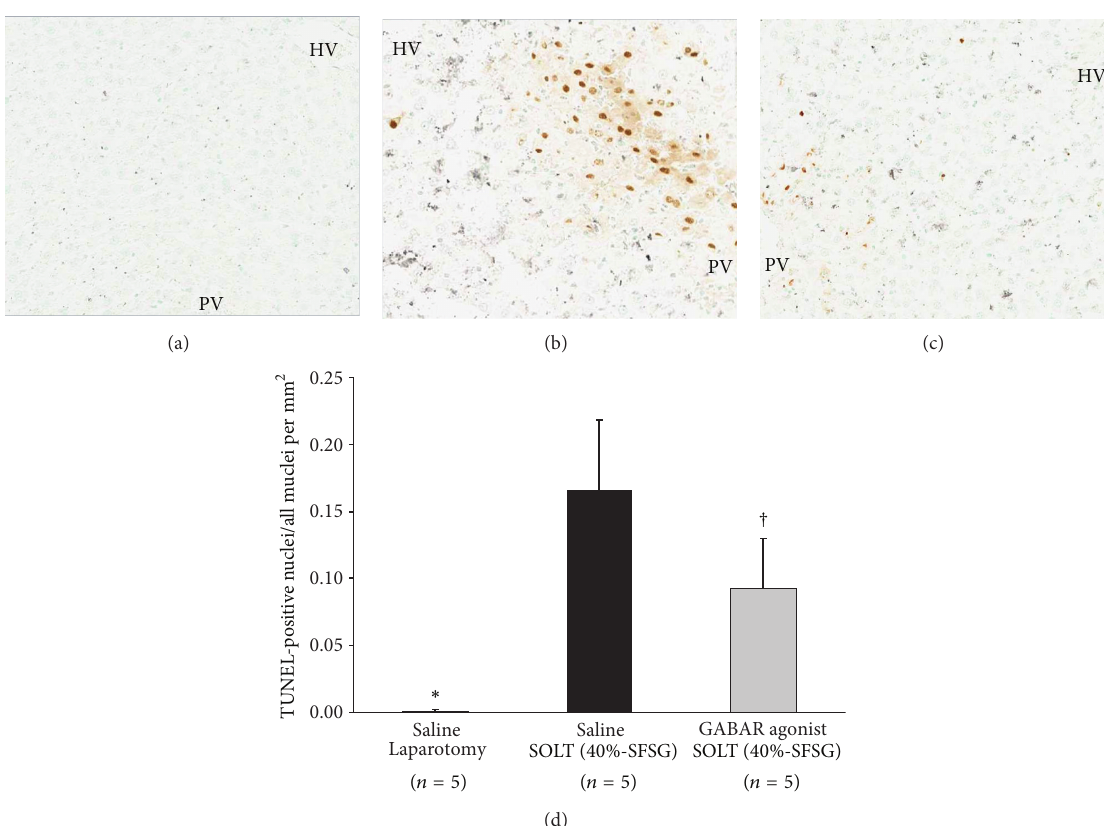
Figure 3: Immunohistological assessment by TUNEL. (a) Laparotomy with saline: TUNEL, × 100. (b) SOLT with saline: TUNEL, × 100. (c) SOLT with GABAR agonist: TUNEL, × 100. (d) Ratio of TUNEL-positive nuclei. There were significant differences between laparotomy and SOLT with saline ( 𝑃 < 0.05 ∗ ) and between SOLT with saline and SOLT with GABAR agonist ( 𝑃 < 0.05 † ). GABAR, 𝛾 -aminobutyric acid receptor; HV, hepatic vein; SFSG, small-for-size graft; SOLT, split orthotopic liver transplantation; PV, portal vein; and TUNEL, terminal deoxynucleotidyl transferase-mediated deoxyuridine triphosphate nick-end labeling. 2.59 ± 0.66 ; 𝑃 = 0.0007 ) and between SOLT with saline and SOLT with GABAR agonist ( 2.59 ± 0.66 versus 0.83 ± 0.25 ; 𝑃 = 0.0005 ) (Figure